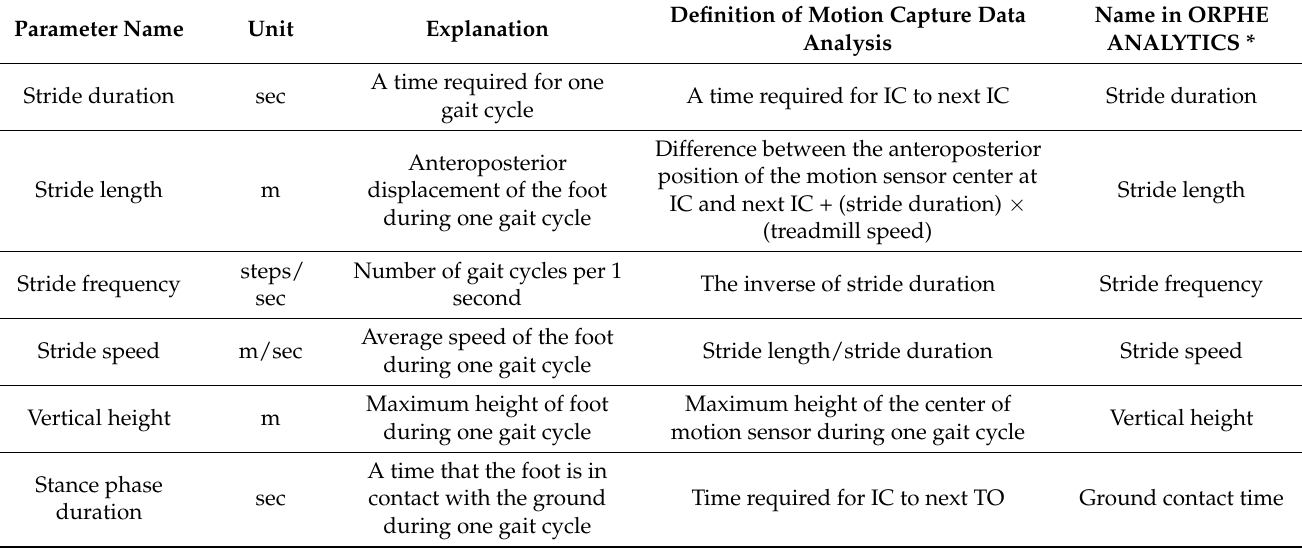
Table 1. Gait parameters and their